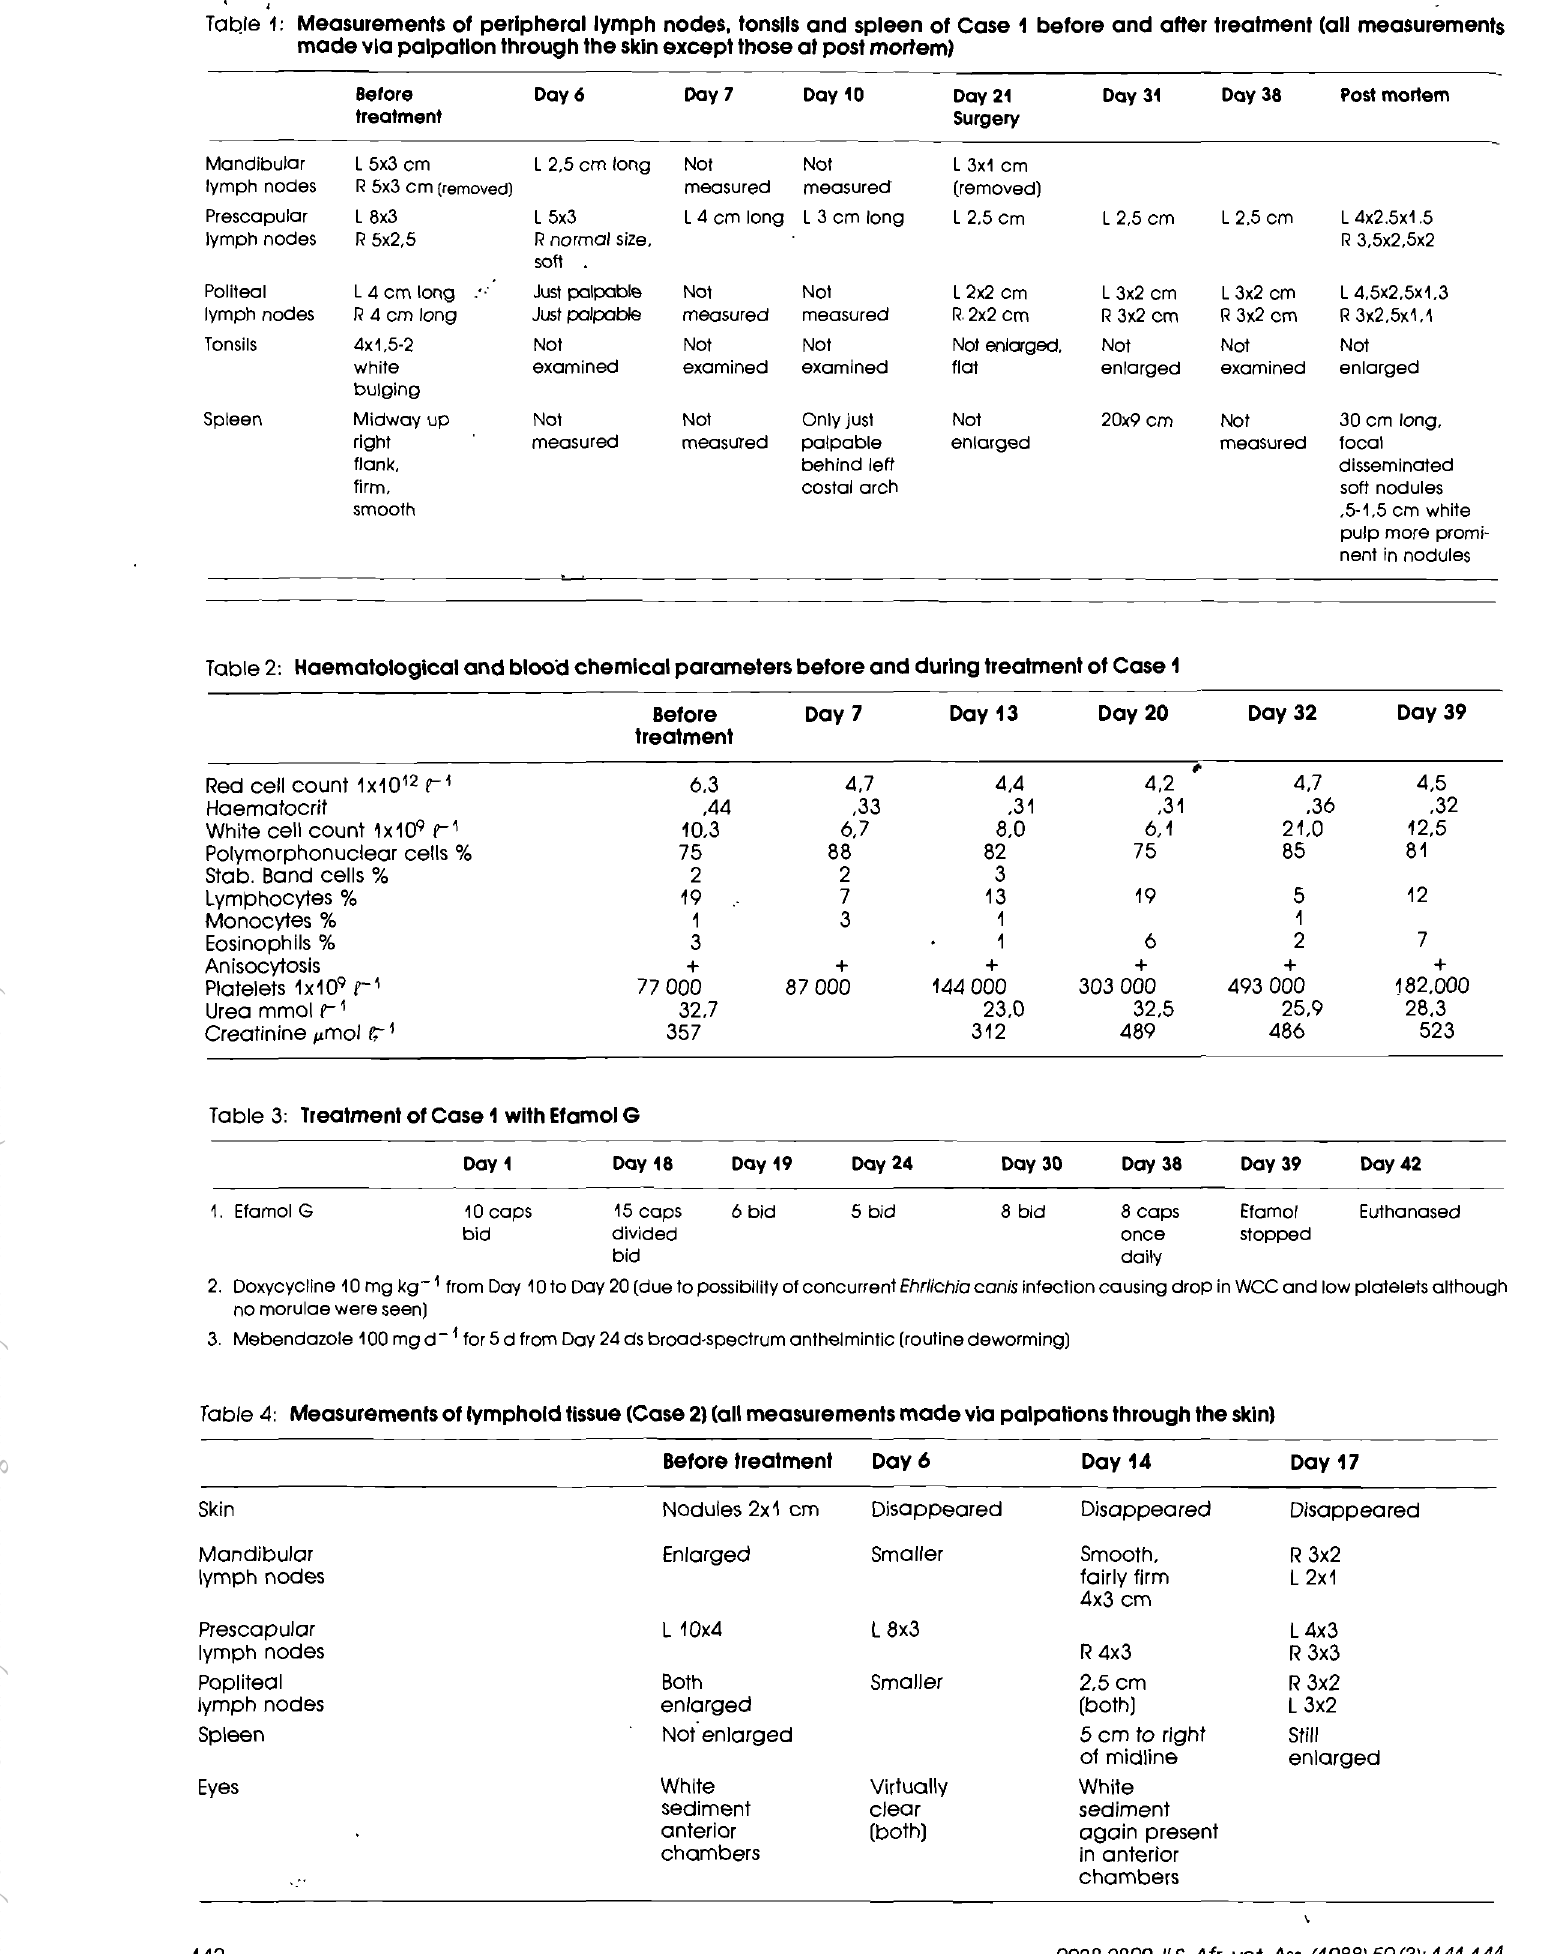
Table 4: Measurements of lymphoid tissue (Case 2) (all measurements made via palpations through the skin)